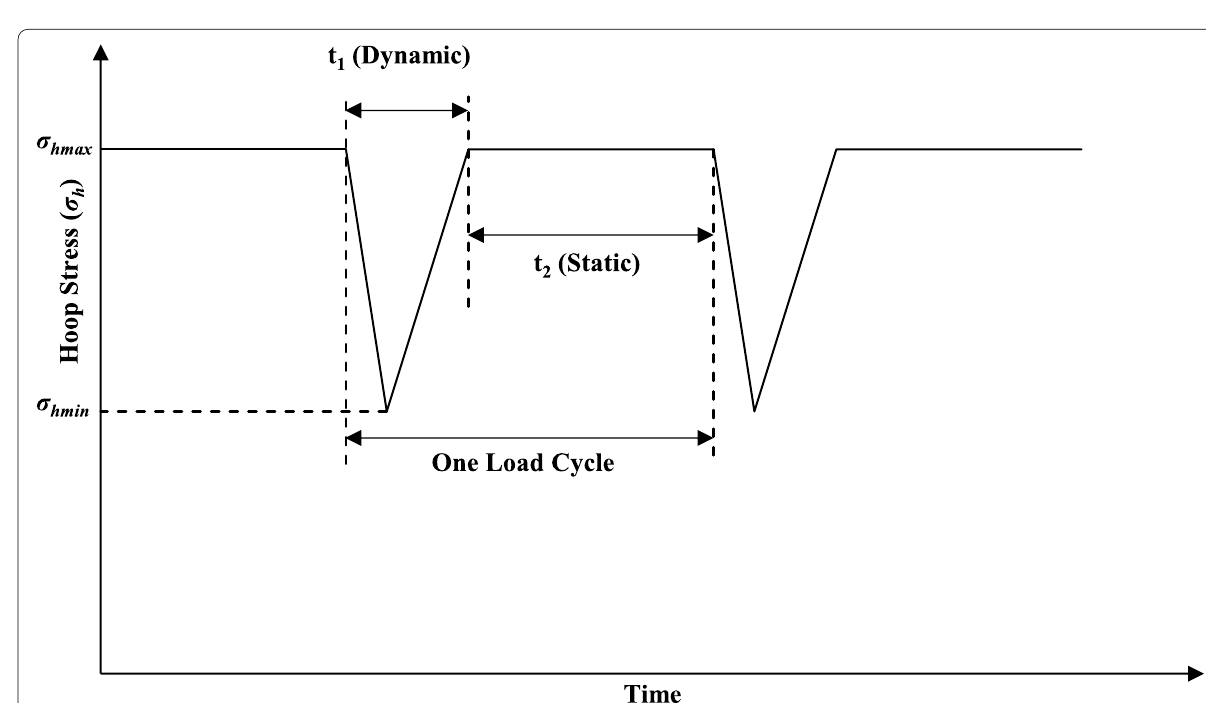
Fig. 4 Stress cycle applied within a given test period for a pipe